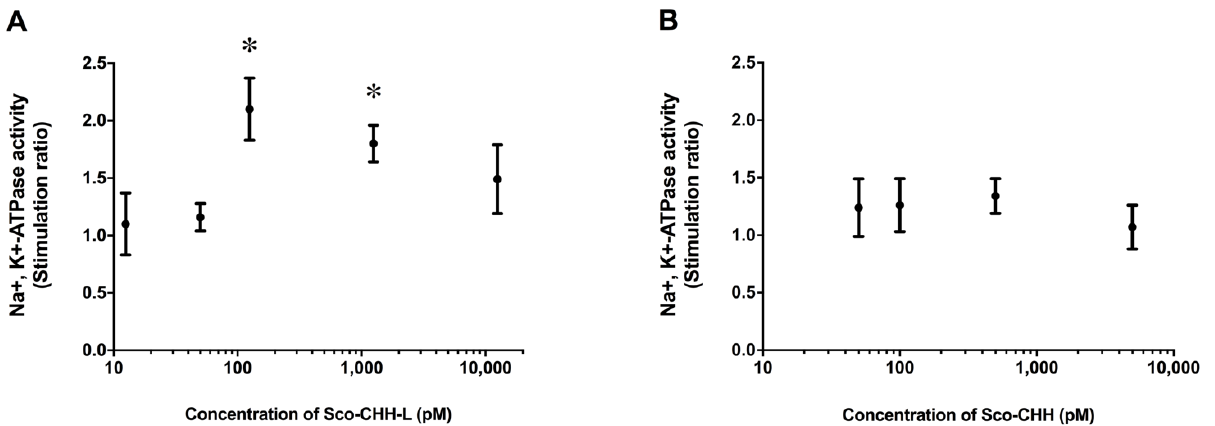
Figure 1. In vitro effects of Sco-CHH-L and Sco-CHH on the Na + , K + -ATPase activity in posterior gills of the mud crab Scylla olivacea. The posterior gills (gill 6) were dissected and received perfusion of ( A ) Sco-CHH-L (12.5, 50.0, 125.0, 1250.0, and 10,000 pM) or ( B ) Sco-CHH (50.0, 100.0, 500.0, and 5000.0 pM). Data are means ± SEM and expressed as the stimulation ratio. n = 4 for each treatment. The asterisk (*) indicates significantly different from vehicle control (saline treatment) at 5% level.